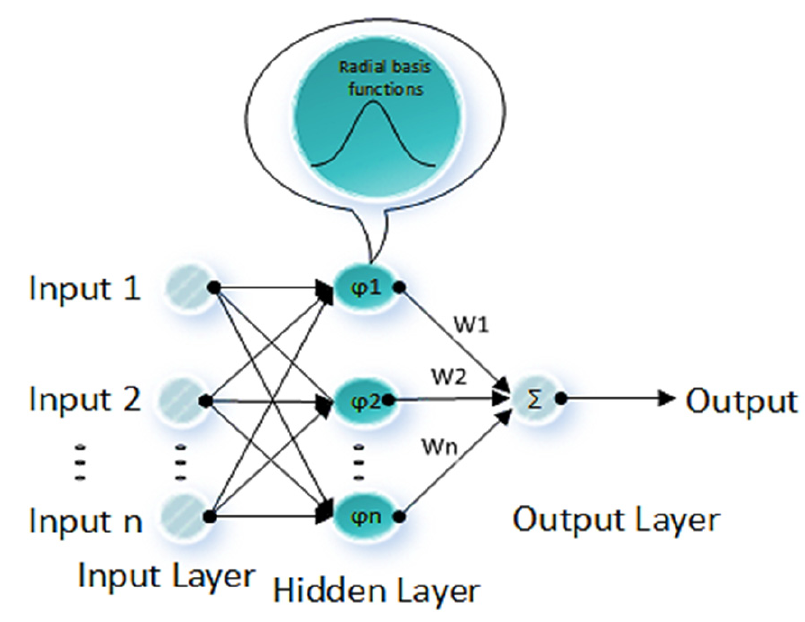
Figure 4. The structure of an RBF neuron network.